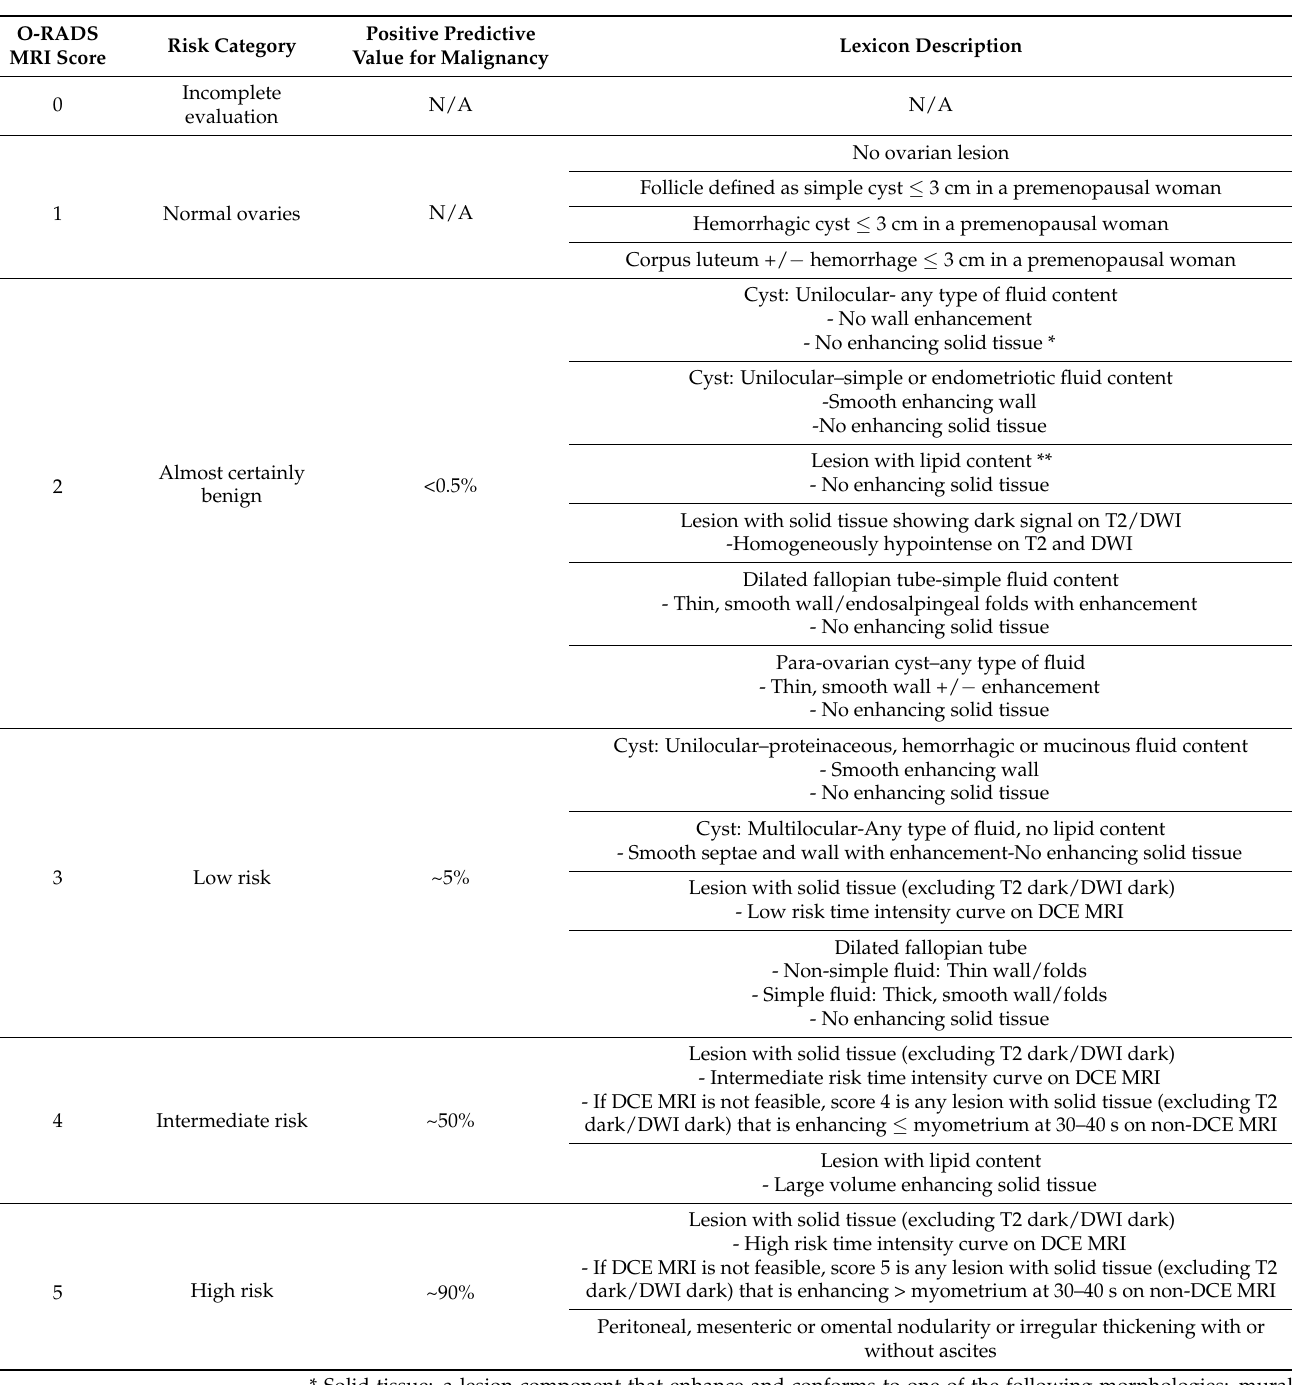
Table 2. O-RADS MRI Risk Stratification and Management